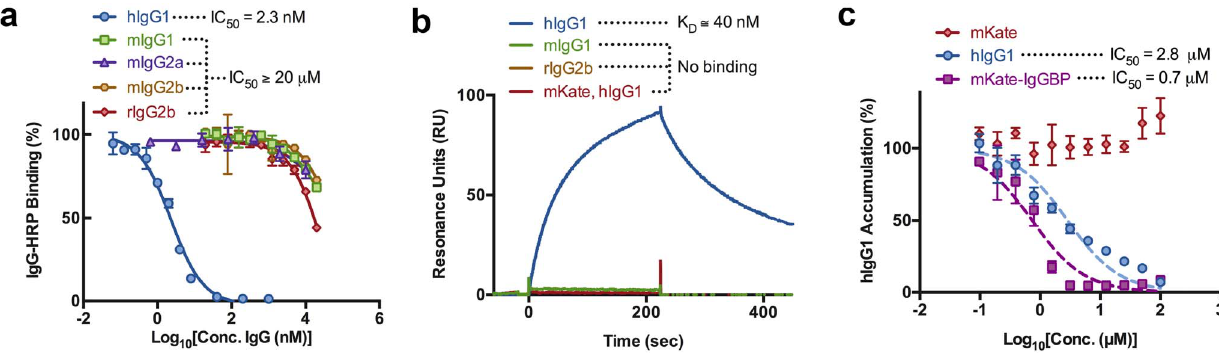
Figure 3. IgGBP fusion results in specific and high affinity binding to human IgG1 at a site overlapping the FcRn. ( a ) Competition ELISA between dIgG-HRP and unlabeled IgGs binding to mKate-IgGBP coated plates. ( b ) Sensograms demonstrating mKate-IgGBP (100 nM) binding to immobilized hIgG1 but not mIgG1 or rIgG2b. Unmodified mKate lacks binding to immobilized hIgG1 by SPR. ( c ) Competition of labeled hIgG1 accumulation in MDCK hFcRn-EYFP/h b 2 m cells at pH 6 by unlabeled hIgG1, mKate-IgGBP, and mKate. MDCK hFcRn-EYFP/h b 2 m cells were co- incubated with 1 m M labeled hIgG1-TAMRA and increasing concentrations of unlabeled hIgG1, mKate-IgGBP, and mKate for 1 hr at 37 u C and analyzed by FACS as described in the methods section. The mean fluorescent intensity (MFI) of each test protein was normalized to the average MFI of hIgG1-TAMRA accumulation in MDCK hFcRn-EYFP/h b 2 m cells in the absence of unlabeled competitor and plotted as the % of hIgG1-TARMA accumulation as a function of competitor concentration. The data shown are the mean and error bars indicate